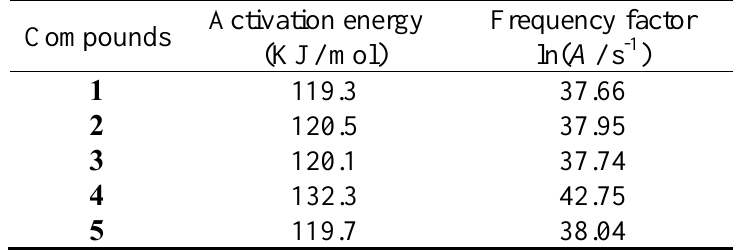
Table 3. Results of kinetic experiments a) for the